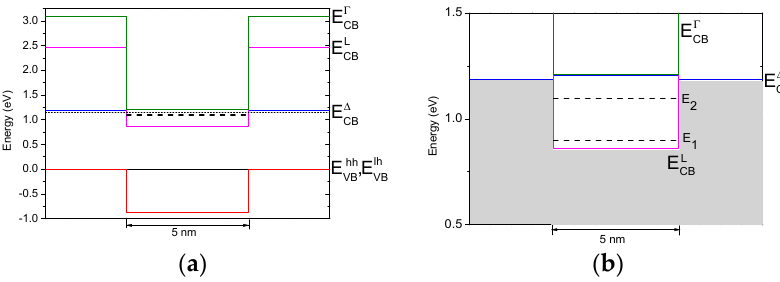
Figure 17. Band alignment for a dislocation in a MOSFET channel. A uniaxial tensile strain of ε = +0.1 and a radius of the dislocation of R = 2.5 nm were assumed. An overview about the energies of the conduction band minima at Γ , L, and Δ as well as valence band maxima of heavy holes (hh) and light holes (lh) extracted from band structure calculations ( a ). Detail of the conduction band forming the quantum wire ( b ). The dashed lines characterize the first energy levels calculated for the quantum wire.